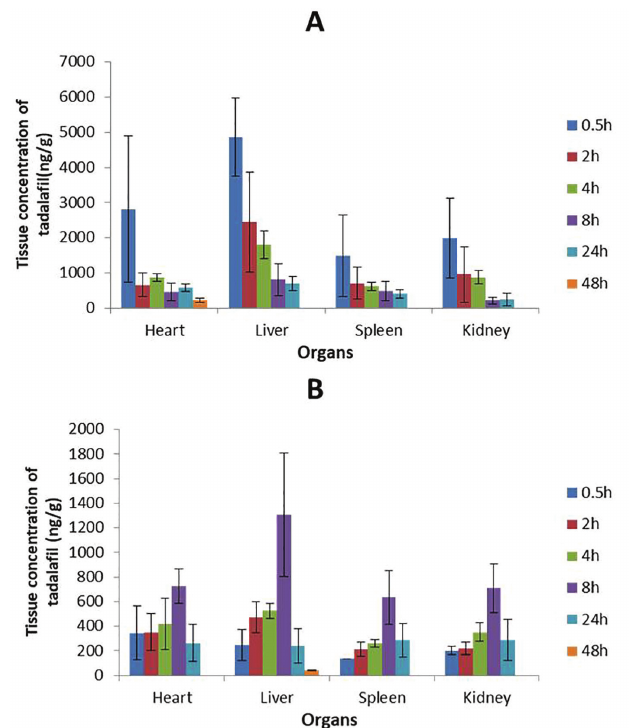
FIGURE 8 - Tissue distribution at different time points in rat after